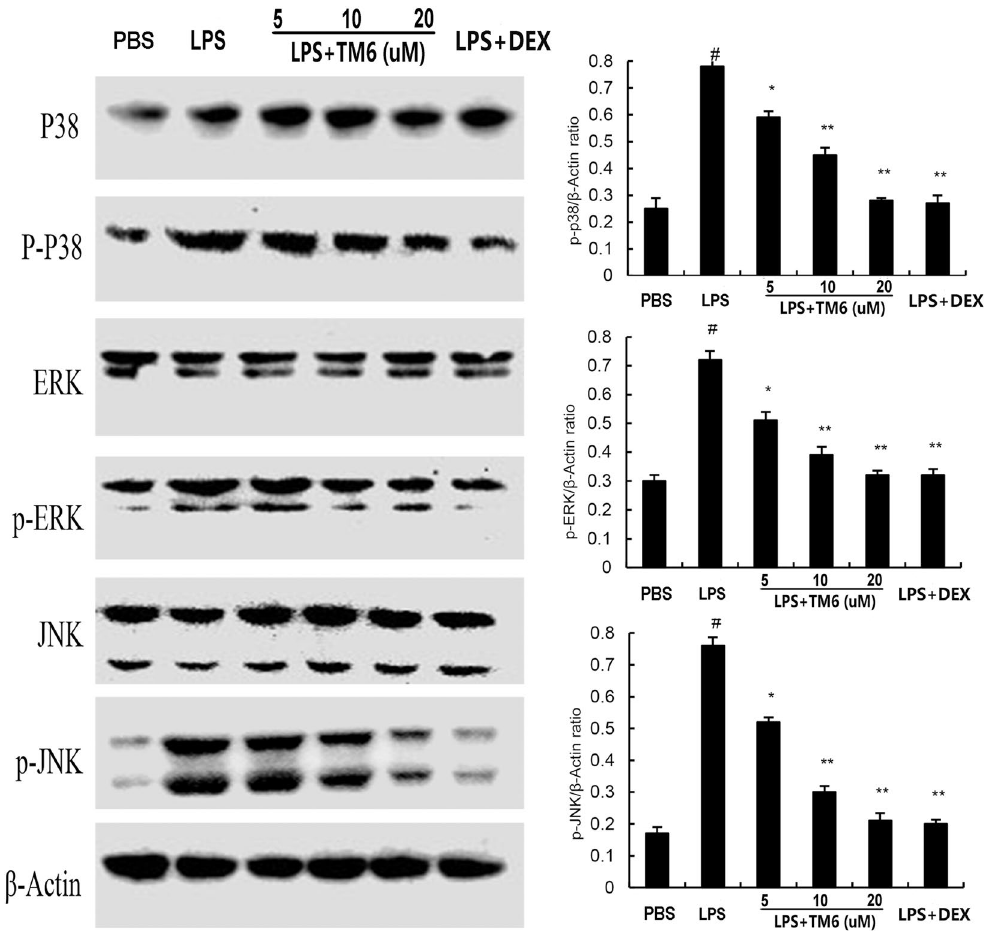
Figure 9. The effect of TM6 on MAPK pathway. Alveolar macrophages were pretreated with TM6 (5, 10 and 20 µ M) for 1 hour and then treated with LPS for 1 hour. MAPK protein samples were analyzed by western blot with specific antibodies. β -actin was used as a control. The values presented are the means ± SEM of three independent experiments, # P < 0.01 is significantly different from the control group; * P < 0.05 and ** P < 0.01 are significantly different from the LPS